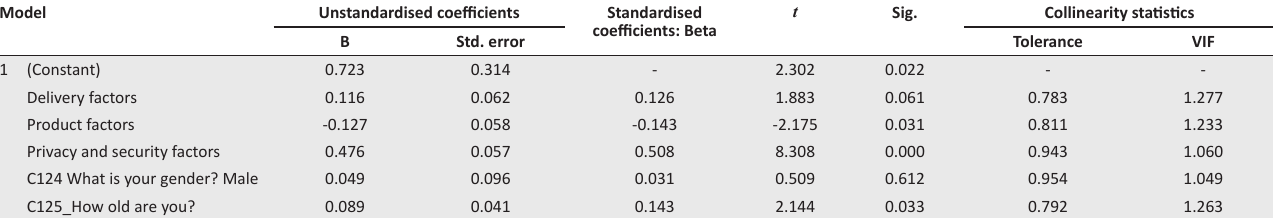
TABLE 6 : Collinearity statistics: Coefficients. † Model Unstandardised